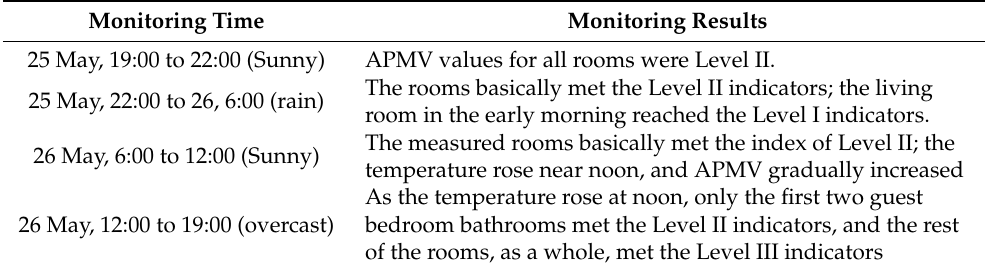
Table 5. APMV thermal and humid environment stages: actual test evaluation.